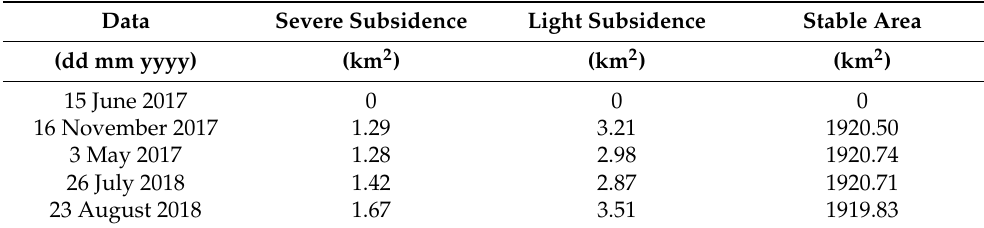
Table 3. Comparison of subsidence area changes in different periods.